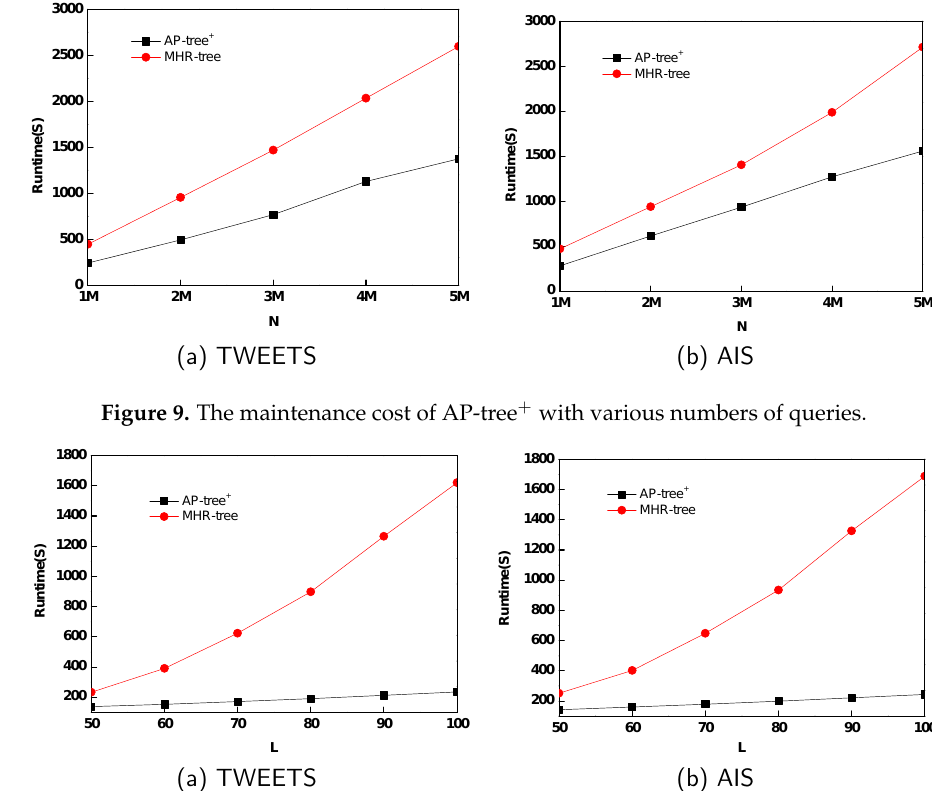
Figure 10. The maintenance cost of AP-tree + comparing with MHR-tree with various numbers of min-wise hashing